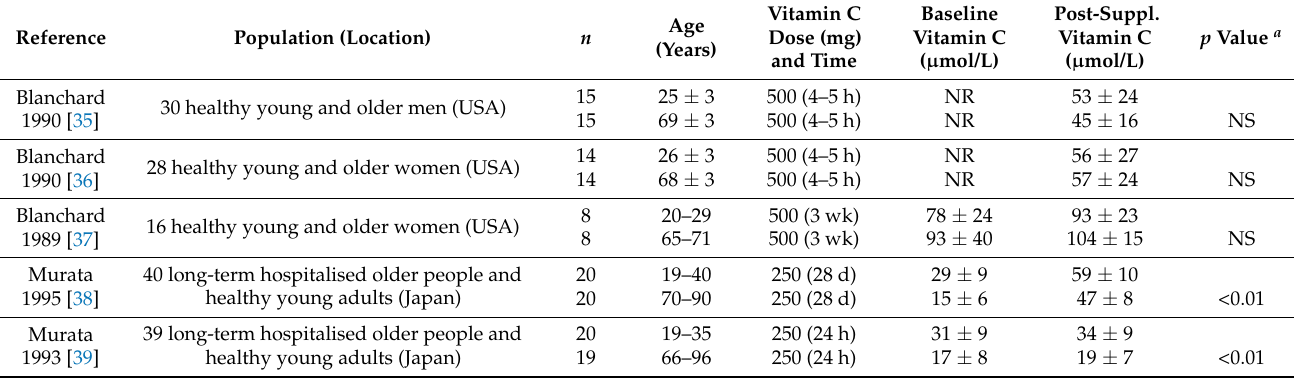
Table 2. Vitamin C status relative to intake stratified by age.